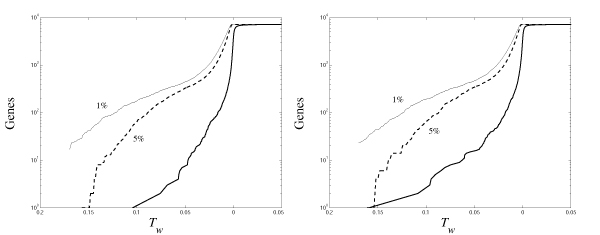
: Observed Tw(j) distribution computed on the Leukemia data set, compared to randomly per-mutated class distinctions. The number of genes highly expressed in a) ALL and b) AML is shown on y-axis.